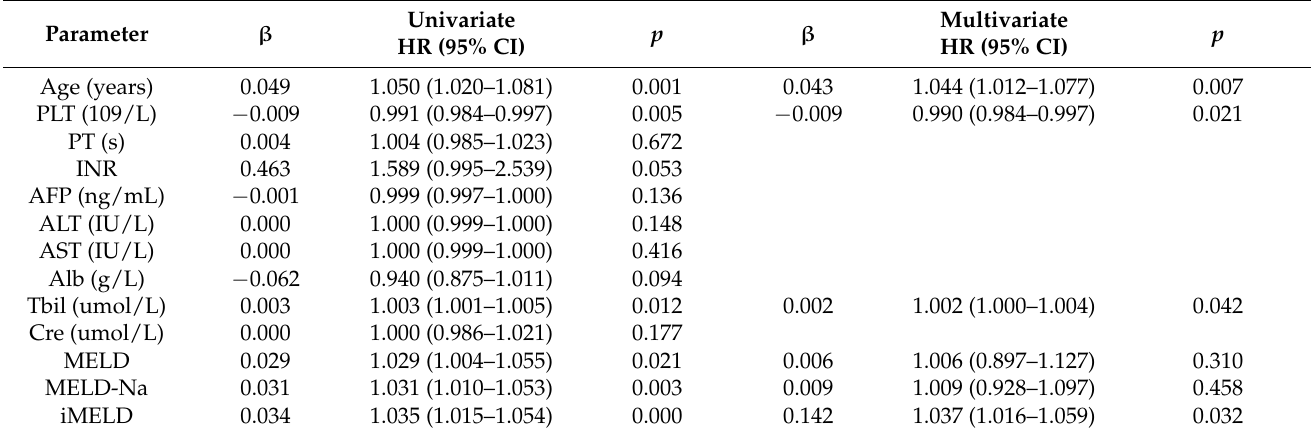
Table 3. Univariate and multivariate Cox regression analysis of 180-day